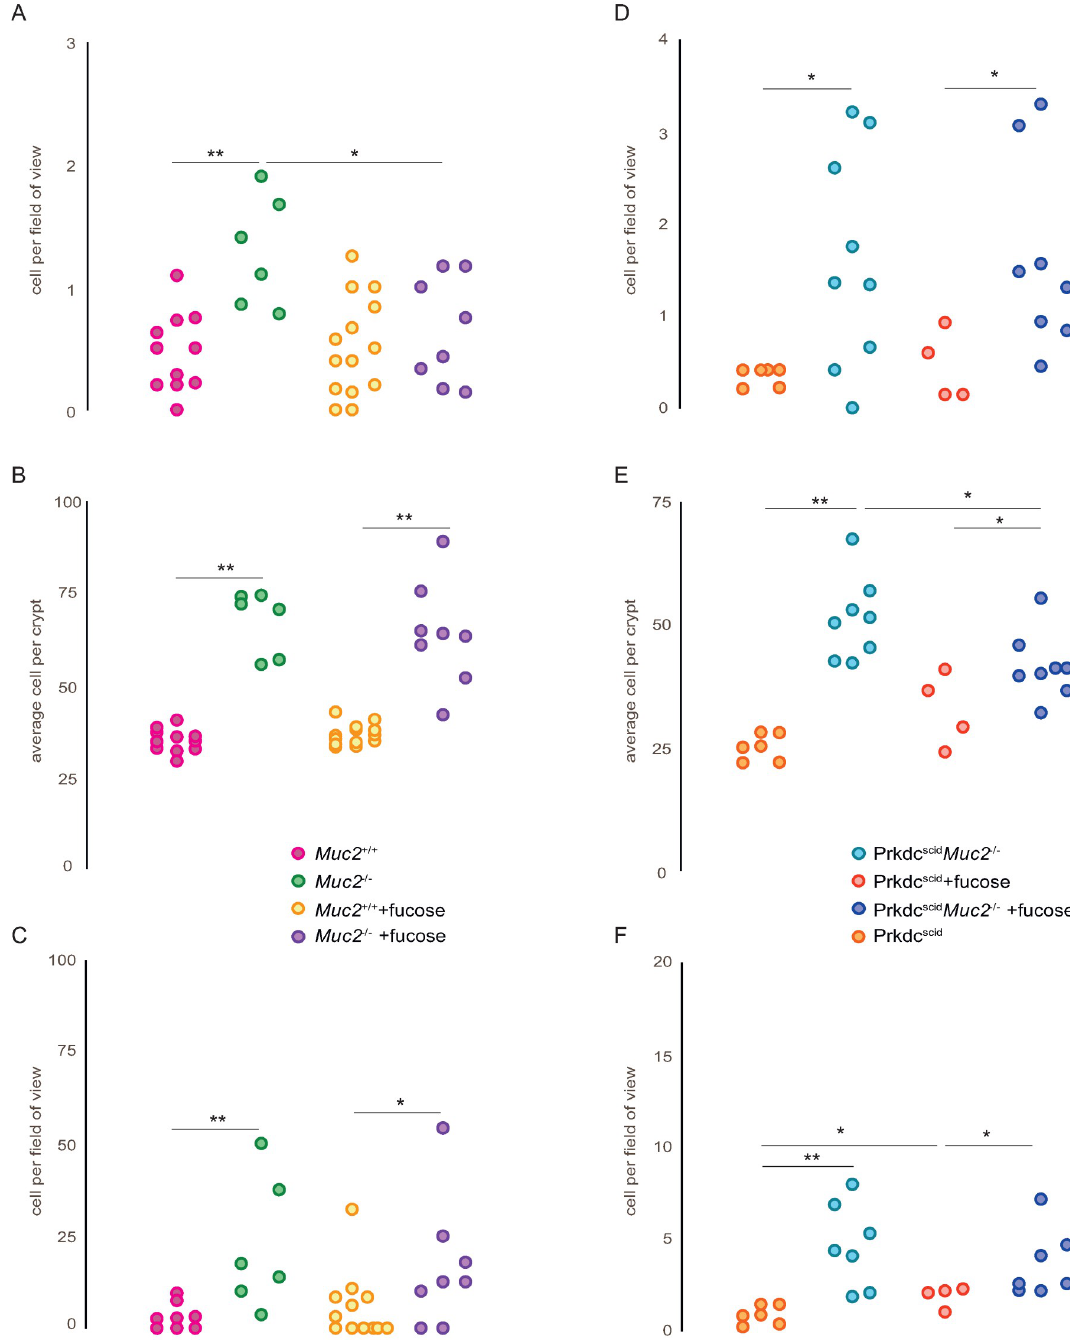
Fig 2. Histological markers of inflammation in the distal colon. ( � = p < 0.05, �� = p < 0.01, Mann-Whitney u-test) (A) Number of macrophages per field of view in Muc2 −/− and Muc2 +/+ mice with and without L-fucose treatment, (B) Number of cells per crypt in Muc2 −/− and Muc2 +/+ mice with and without L-fucose treatment (C) Number of eosinophils in Muc2 −/− and Muc2 +/+ with and without L-fucose treatment (D) Number of macrophages per field of view in Prkdc SCID Muc2 −/− and Prkdc SCID mice with and without L-fucose treatment (E) Number of cells per crypt in Prkdc SCID Muc2 −/− and Prkdc SCID mice with and without L-fucose treatment (F) Number of eosinophils in Prkdc SCID Muc2 −/− and Prkdc SCID mice with and without L-fucose treatment.